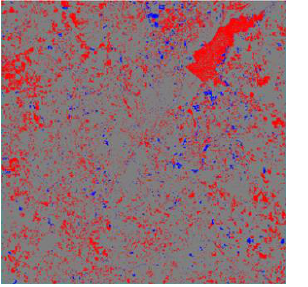
Figure 3. Change detection result of pixel-base method with dNDVI